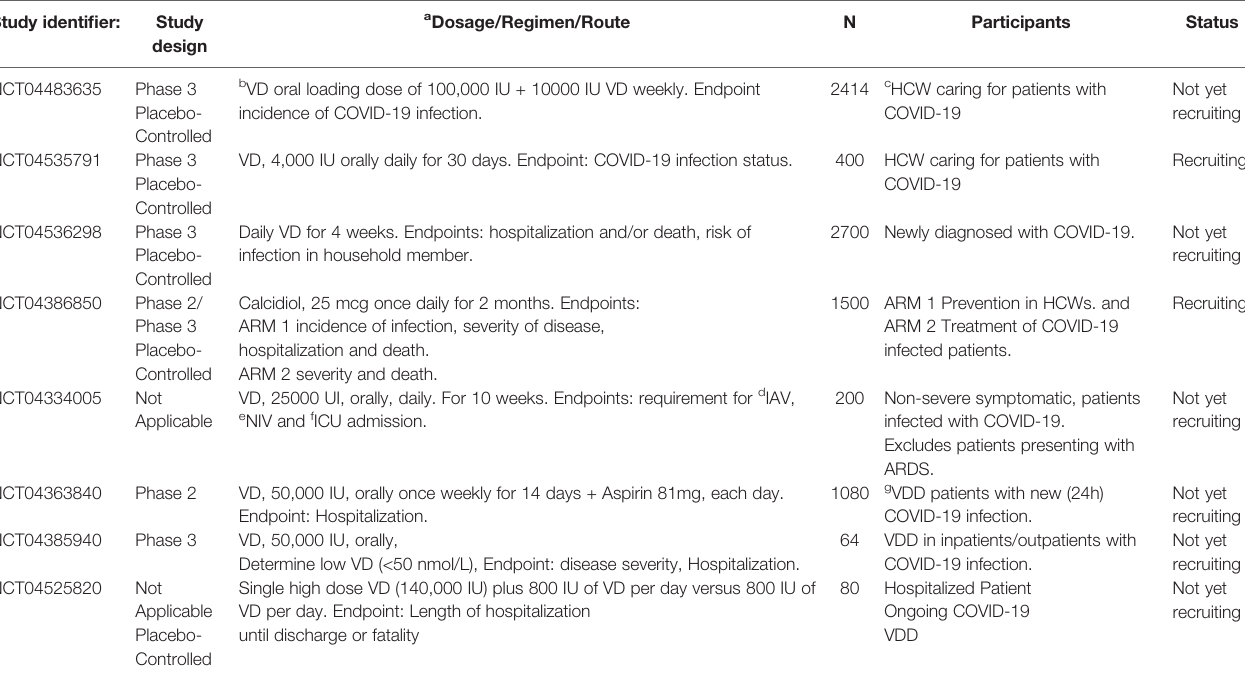
TABLE 2 | Representative interventional clinical trials investigating Vitamin D in patients with COVID-19. Study identi fi